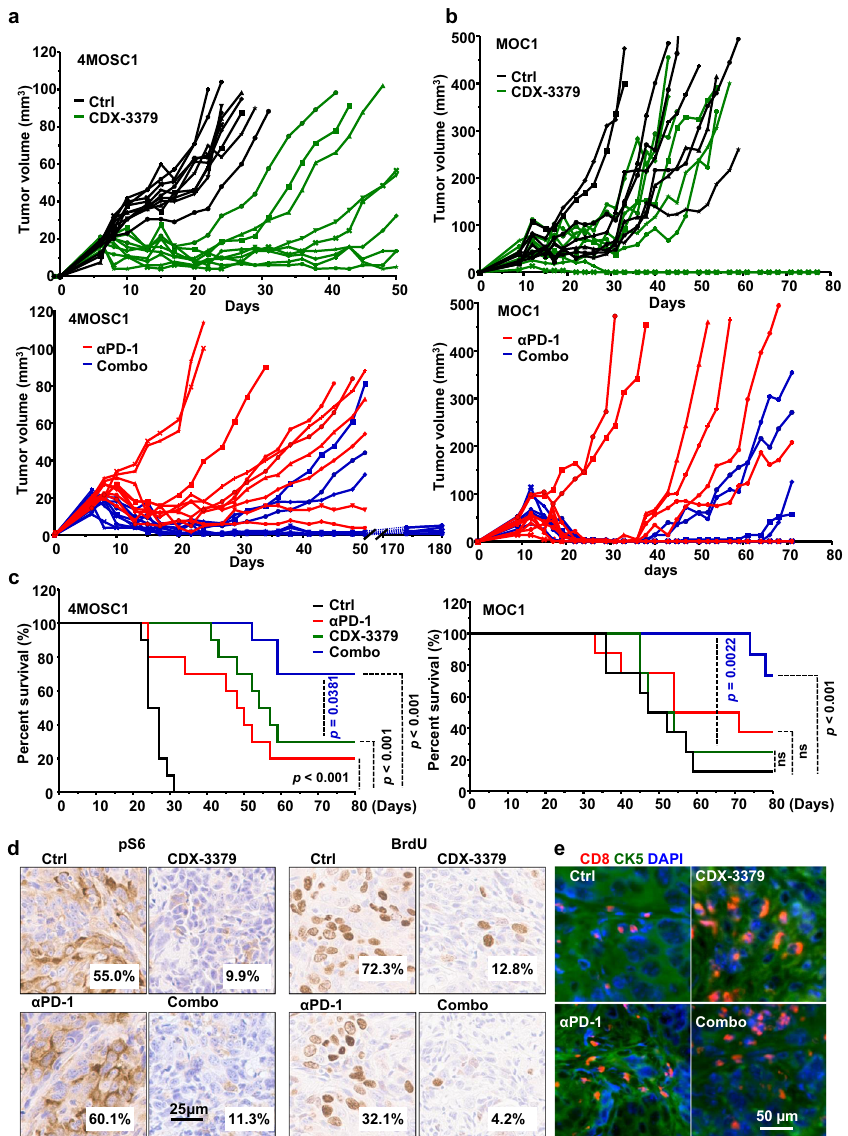
Fig. 6 Anti-tumor effect of HER3 inhibition in syngeneic HNSCC models and increased durable responses to PD-1 blockade. a C57Bl/6 mice were implanted with 1 × 10 6 of 4MOSC1 cells into the tongue. After tumors reached ~30 mm 3 , mice were treated IP with of isotype control, CDX-3379 (20 mg/ kg), anti-PD-1 (10 mg/kg), or a combination of CDX-3379 and PD-1 three times per week for 3 weeks. Individual growth curves of 4MOSC1 tumor-bearing mice are shown ( n = 10 per group). b C57Bl/6 mice were implanted with 2 × 10 6 MOC1 cells into the fl anks. After tumors reached approximate 50 mm 3 , mice were treated same as panel ( a ). Individual growth curves of MOC1 tumor-bearing mice are shown ( n = 8 per group). c A Kaplan – Meier curve showing the survival of mice from panels ( a ) and ( b ). The death of animals occurred either naturally, when tumor compromised the animal welfare, when tongue tumor volume (panel a ) reached 100 mm 3 ( n = 10 mice per group), or when fl ank tumor volume (panel b ) reached 500 mm 3 ( n = 8 mice per group). Two sided log-rank/Mantel – Cox test. d Representative immunohistochemical analysis of pS6 and BrdU in the short-term treatment groups (every other day for three treatments) from panel ( a ). Brown chromogen deposition re fl ects the immunoreactivity; hematoxylin was used as a nuclear counterstain (blue). Scale bars represent 25 μ m. Quanti fi cation from images on the left using Qupath software and the percentage of positive staining are shown on each image. e Immuno fl uorescent staining of CD8 and CK5 in the short-term treatment from panel ( a ). Source data are provided as a Source Data fi